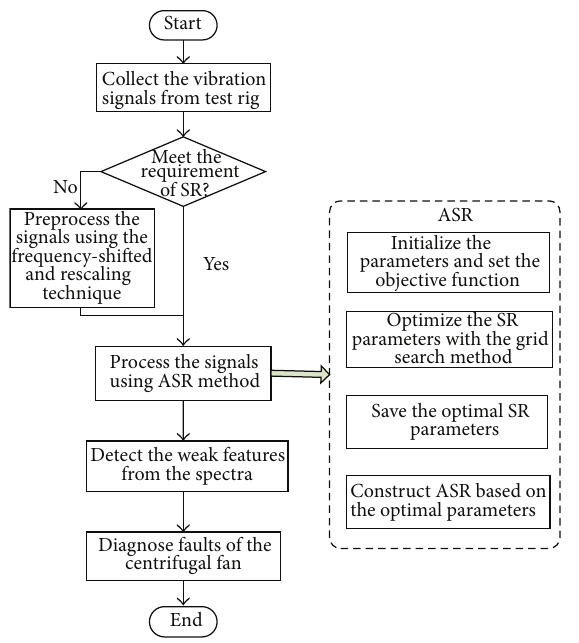
Figure 2: Flow chart of the ASR method.